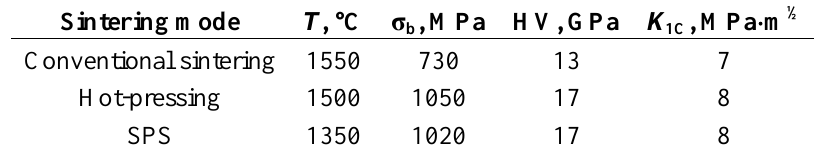
Table 5. Comparison of the mechanical properties of Al different